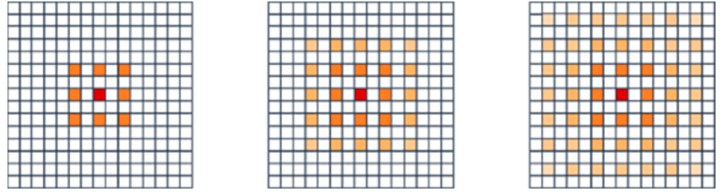
Figure 3. “Gridding artifacts” problem. Receptive-field with dilation rate r = 2.